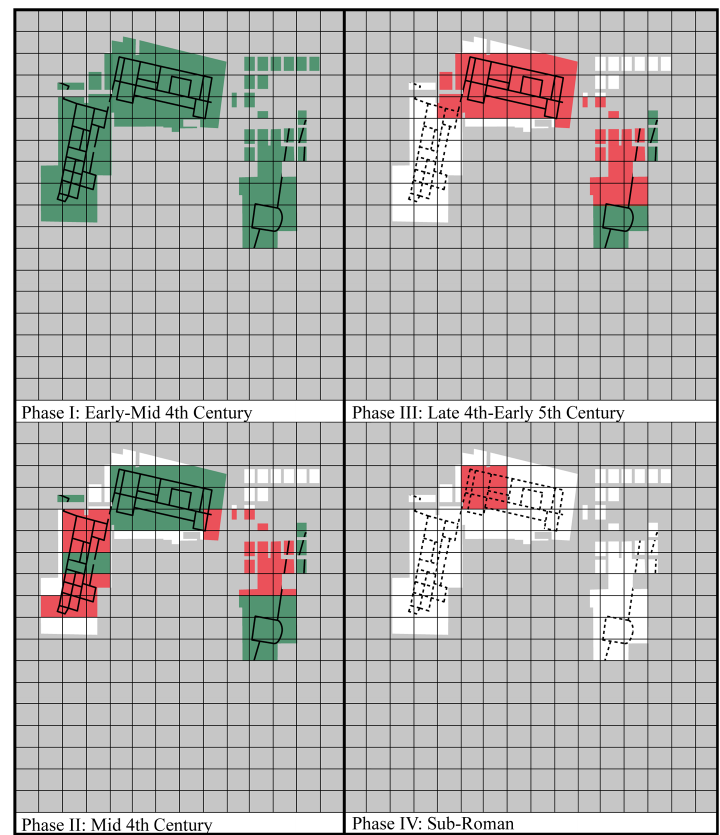
Figure 3: A macro-level view of different activity types at Beadlam (laid out in a 10 × 10 grid) highlighting continued occupation (green), transformation (red), and areas with no information